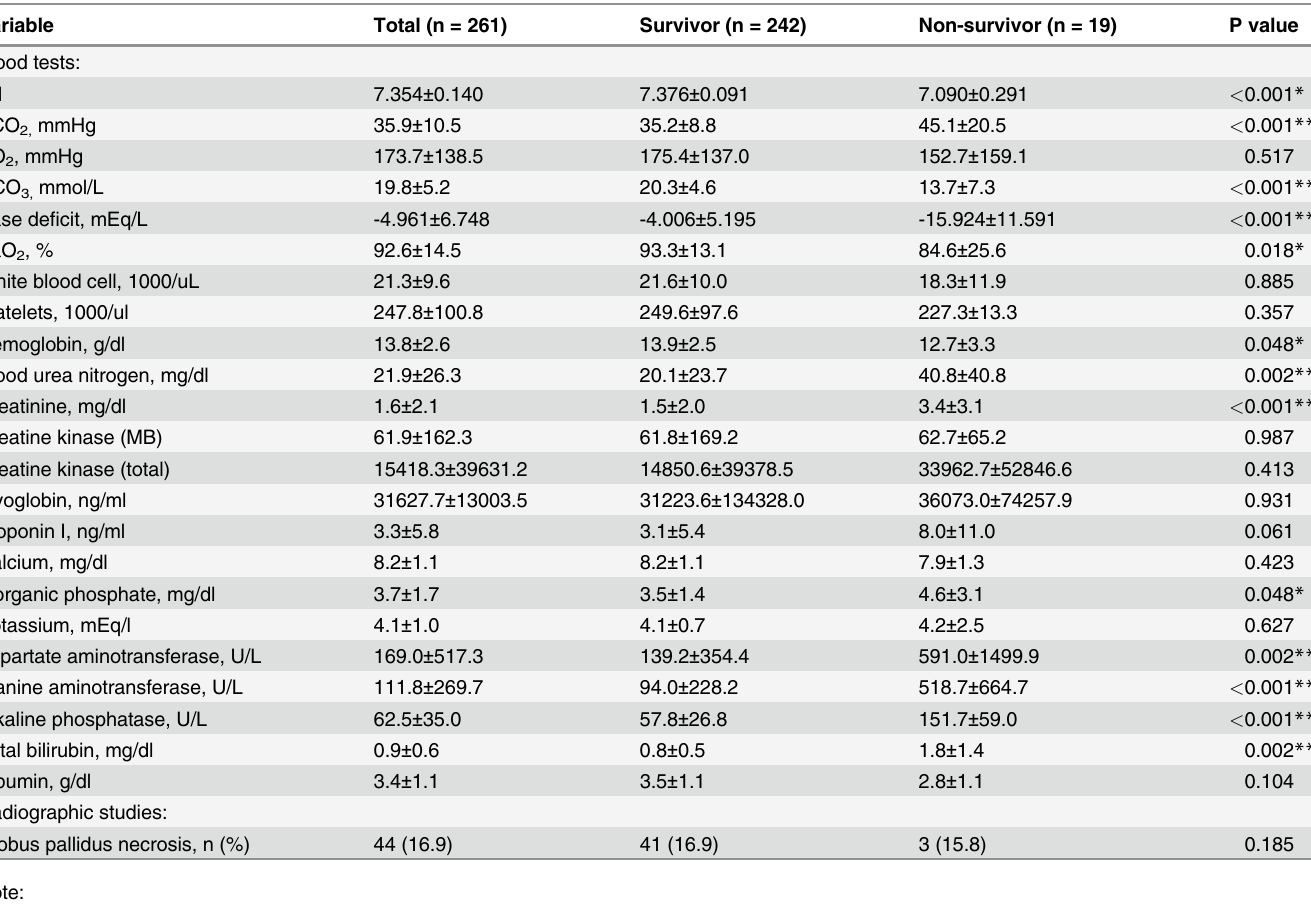
Table 3. Laboratory fi ndings of patients with CO poisoning, strati fi ed according to status at discharge as alive (survivors) or dead (non- survivors).